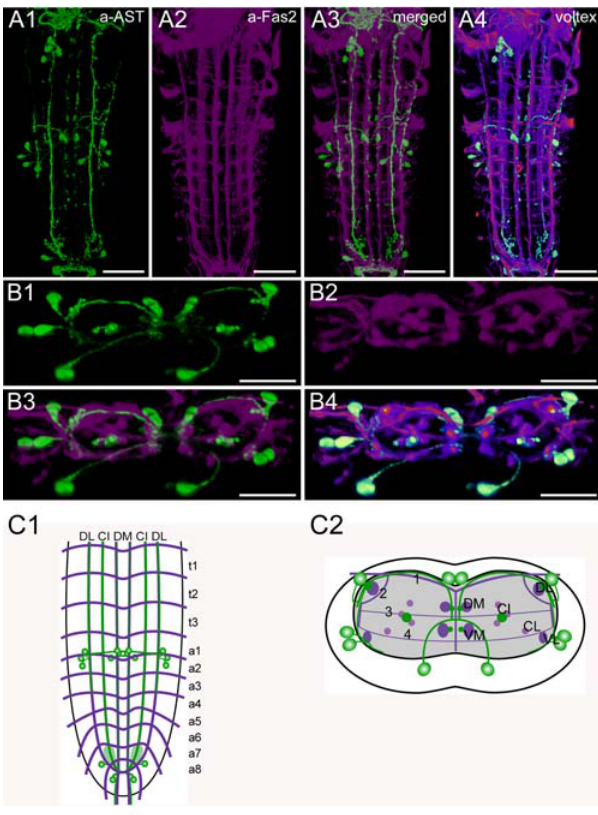
Figure 2. Morphology of AST-A neurons. Mapping of AST-A-IR neurons in whole-mount preparations of the thoracic and abdominal neuro- meres of L3 larva in the Fas2 landmark system. A) Dorsal view. B) Transversal view at the height of neuromere a1/a2. C) Idealized dorsal scheme. D) Idealized transverse scheme. Scale bars: 50 m m in A ), 25 m m in B ). Immunostaining is shown in green, Fas2 in magenta.